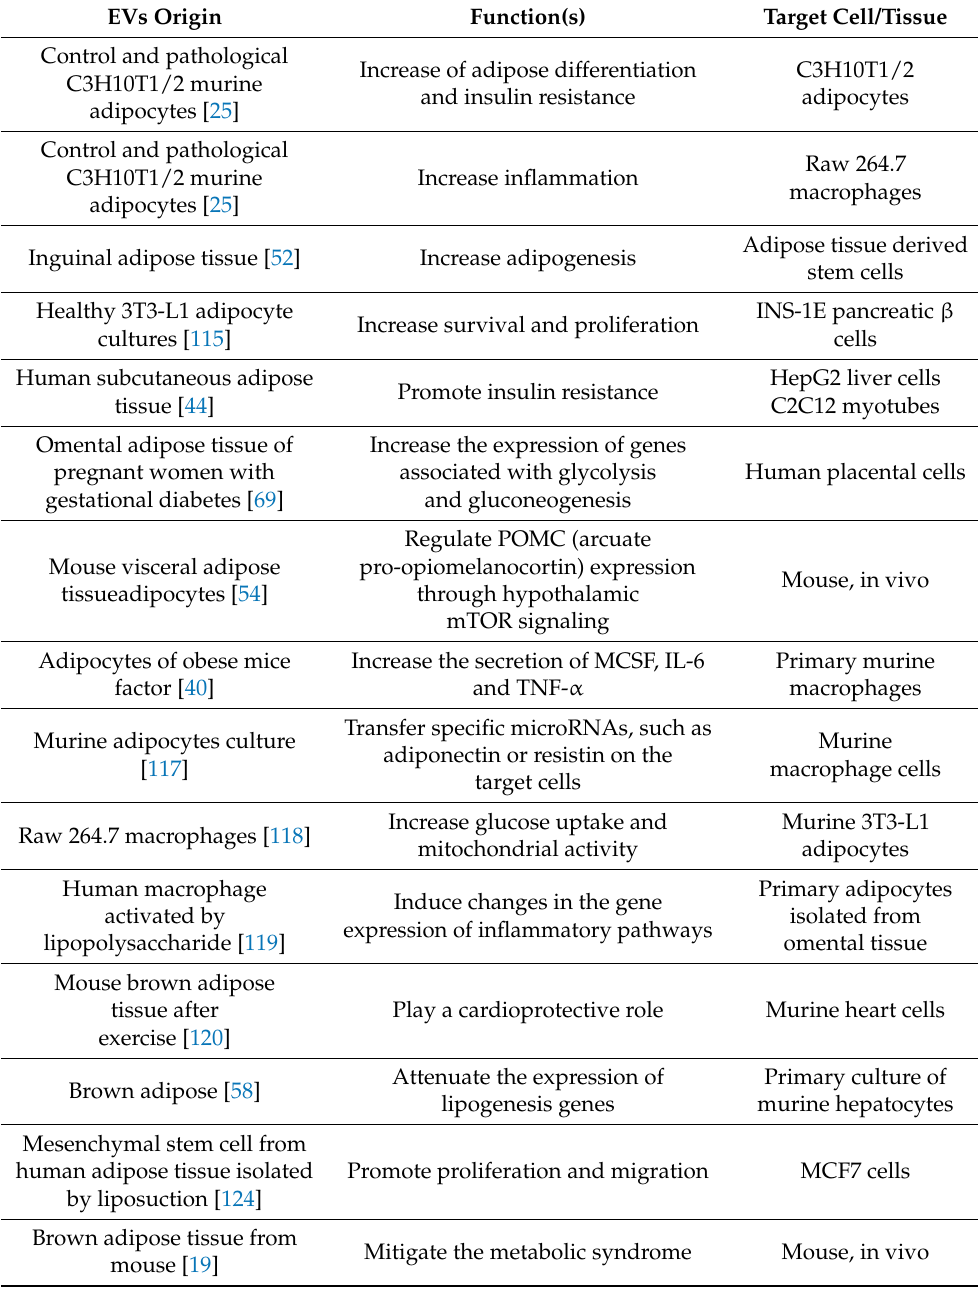
Table 3. Summary of the reviewed publications related to the functionality of the EVs in the context of